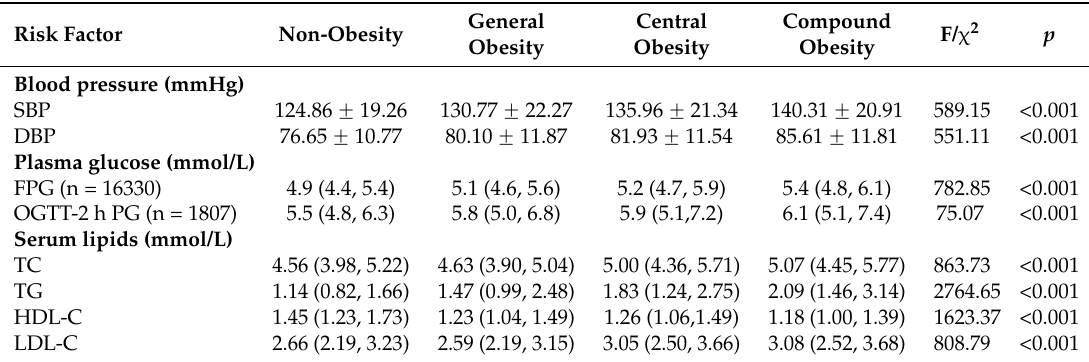
Table 2 describes the level of blood pressure, plasma glucose and serum lipids in different types of obesity. There are significant differences in the four groups of obesity. Table 2. Level of CVD risk factors in different types of